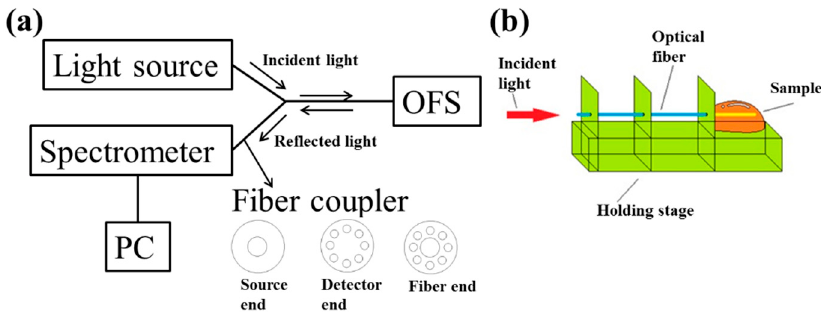
Figure 3. ( a ) The experimental setup, ( b ) he customized fiber-holding stage.